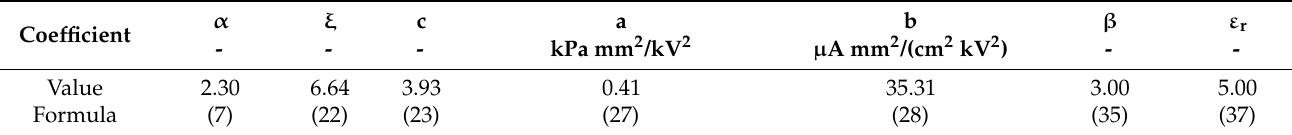
Figure 8. Dependence of the torque M on the blade number n. Figure 9. Dependence of the voltage U h on the blade number n. Figure 7 presents the influence of the radius r w and the radius Ron the braking torque M. Figure 8 shows the dependence of the braking torque M on the blade number n. Figure